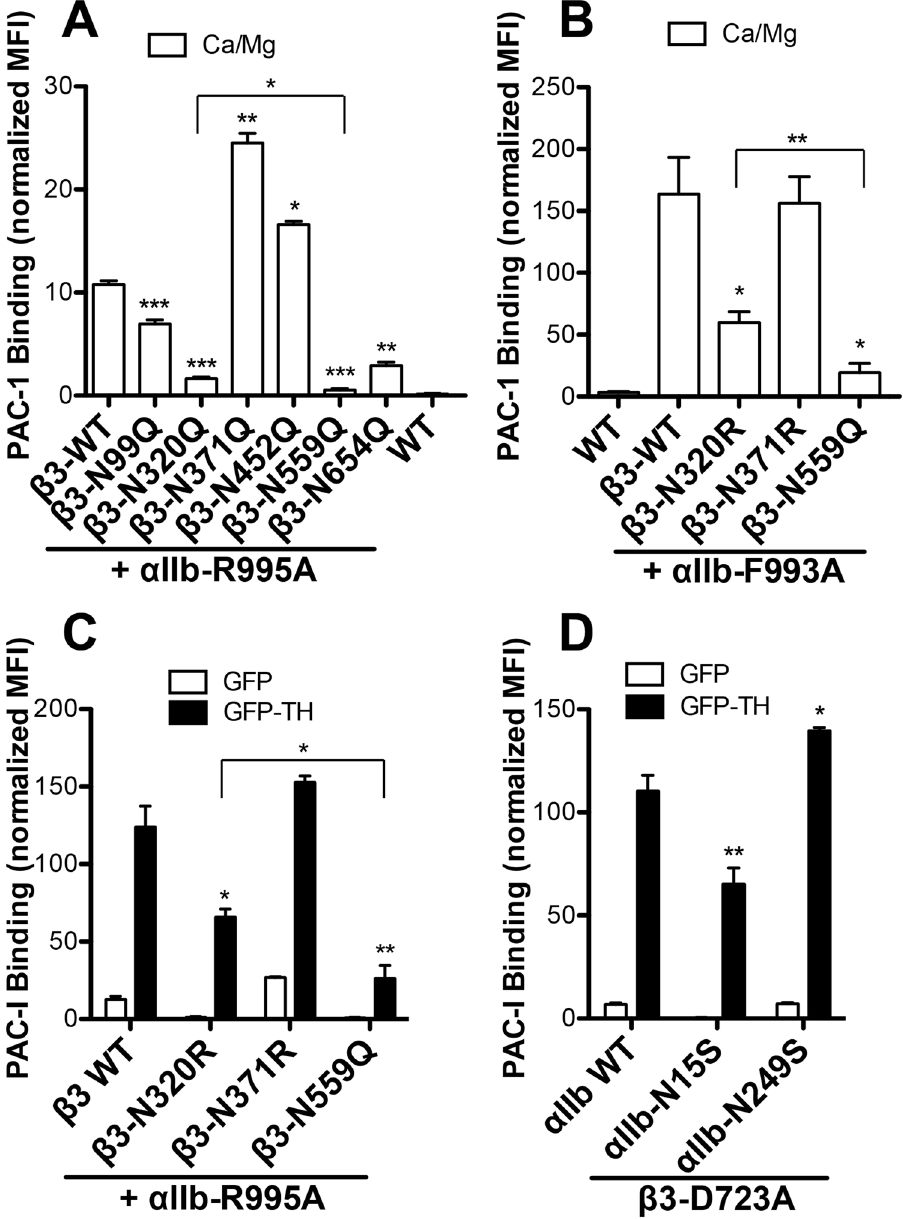
Figure 5. N-glycan deletions decreased α IIb β 3 integrin activation from inside the cell. ( A , B) PAC-1 binding of HEK293FT cells transfected with the indicated β 3 constructs and the α IIb -R995A or α IIb -F993A mutant. (C , D) PAC-1 binding of the α IIb β 3 constructs co-expressed with EGFP or EGFP-Talin1-head (TH) in the HEK293FT cells. The binding was done in the presence of 1 mM Ca 2 + /Mg 2 + (Ca/Mg) and measured by flow cytometry. Data are means ± s.e.m. (n ≥ 3). Two-tailed t-tests were used to compare the wild type (WT) and the mutants in the same condition. * P < 0.05; ** P < 0.01; *** P <